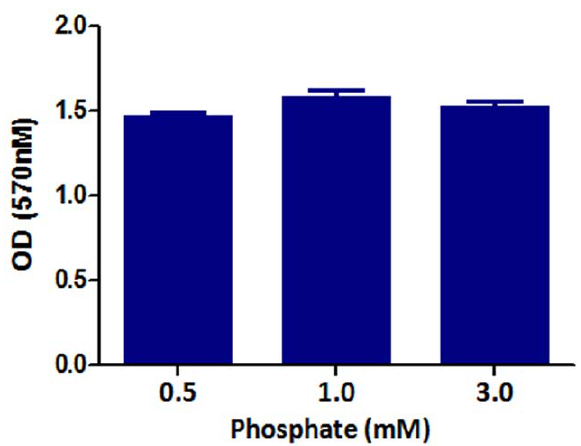
Figure 4. Effect of inorganic phosphate on normal human lung fibroblast proliferation. We examined the effect of exposure to different concentrations of inorganic phosphate for 24 hours on normal human lung fibroblast proliferation. The cell proliferation/viability were validated by the mitochondria-dependent reduction of MTT [3-(4,5- dimethylthiazol-2-yl)-2, 5-diphenyl tetrazolium bromide] to purple formazan as detailed in the Method section. Incubation in media simulating hypophosphatemia (0.5 mM) or hyperphosphatemia (3 mM phosphate) had no effect on fibroblast survival when compared to cells incubated in the medium containing 1 mM